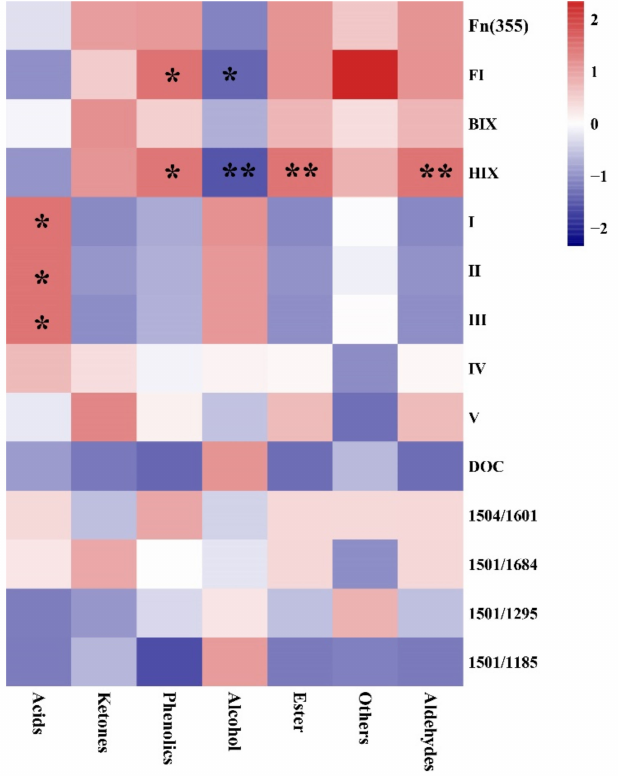
Figure 5. Relationship between DOC, fluorescence spectral indices (HIX, BIX, FI, and Fn (335)), fluo- rescence components (I–V), FTIR spectral parameters (1504/1601, 1504/1684, 1504/1295, 1504/1185), and chemical components. * Correlation was significant at the 0.05 level; ** Correlation was significant at the 0.01